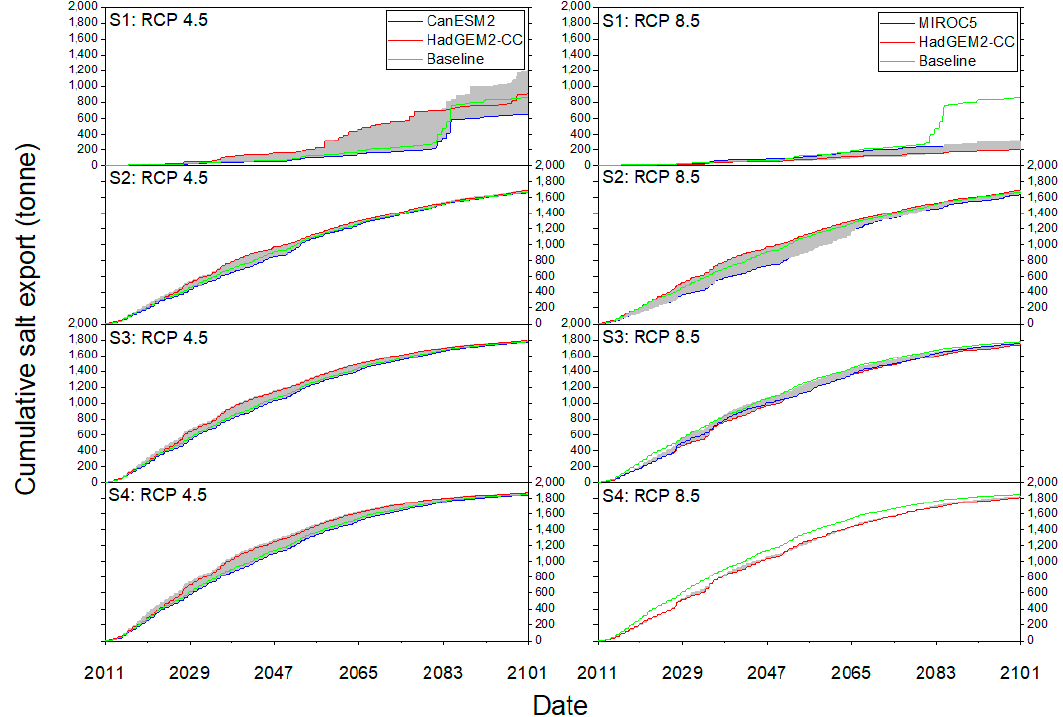
Figure 8. Cumulative salt export across the different partial afforestation configurations and RCP